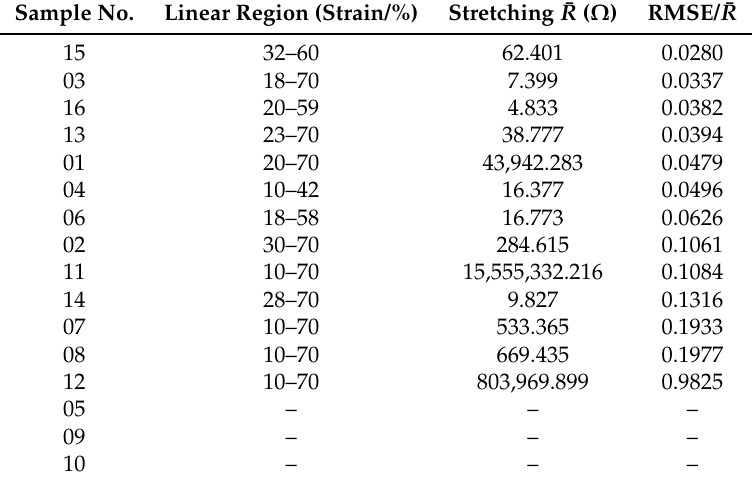
Table 3. Each sample’s linearity performance while stretching (ranked by root-mean-square error (RMSE)). Samples 05, 09, and 10 did not produce usable data, so were excluded from the analysis. Sample No.